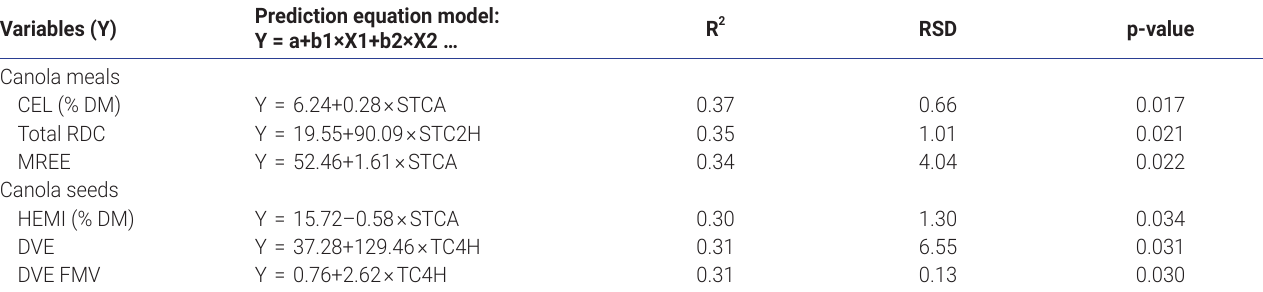
Table 21. Regression analysis to predict Canola carbohydrate parameters from FTIR carbohydrate structures Variables